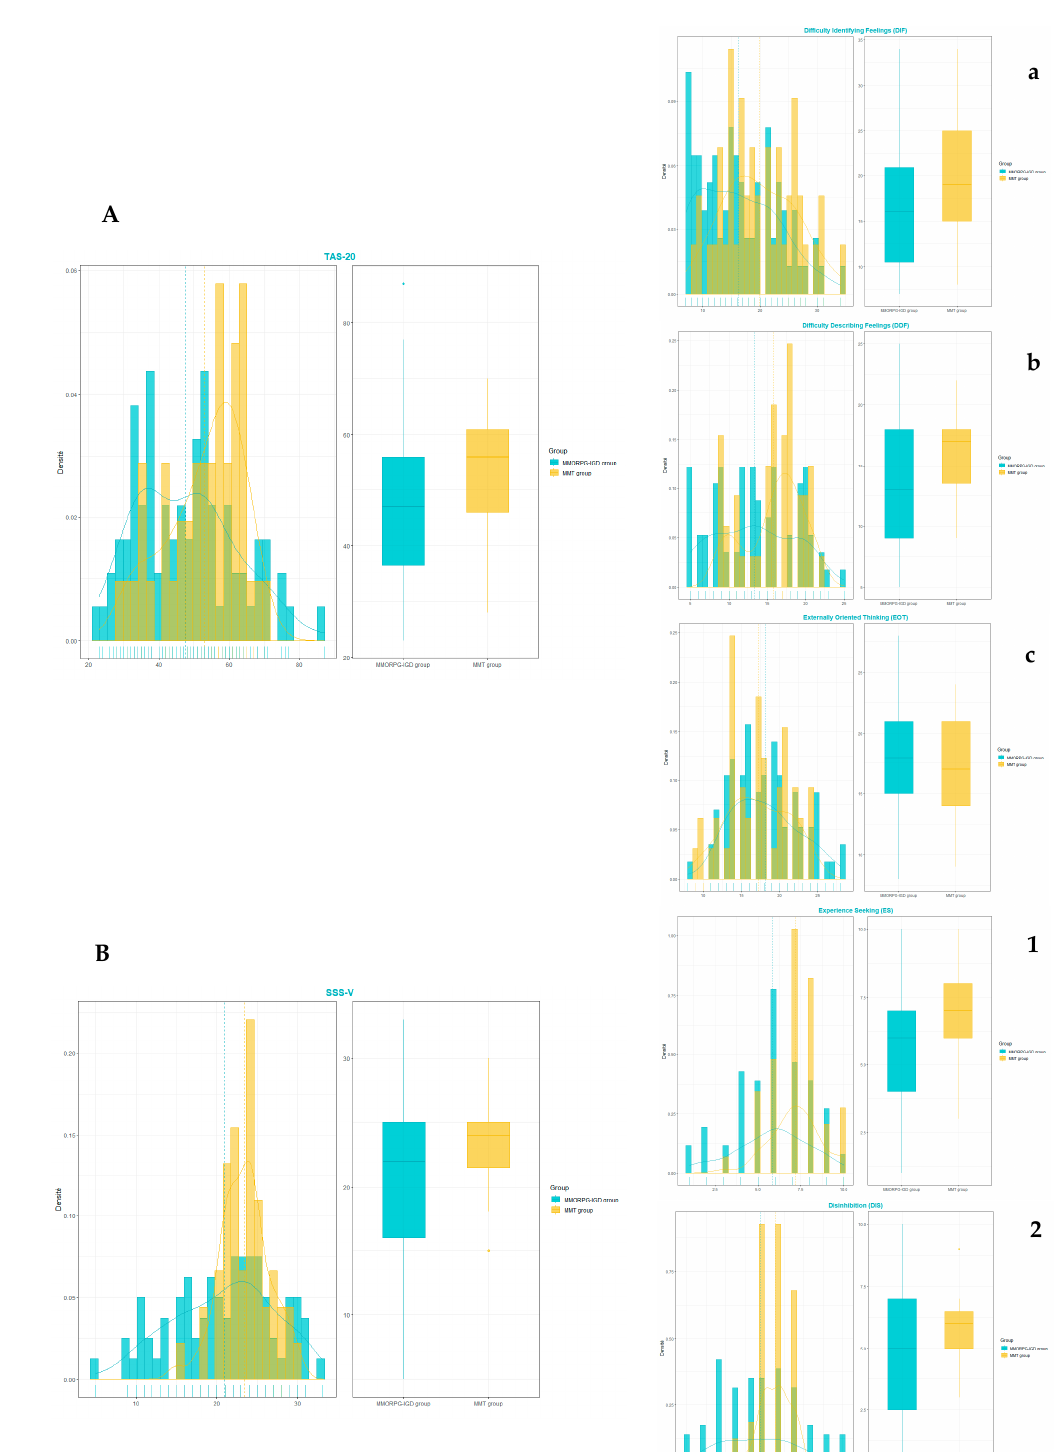
Figure 1. Histogram and box plot comparing the score distributions between MMORPG-IGD and MMT. ( A ) on the TAS-20 and its subcomponents, ( a ) Difficulty Identifying Feelings (DIF), ( b ) Difficulty Describing Feelings (DDF) and ( c ) Externally Oriented Thinking (EOT); ( B ) on the SSS-V and its subcomponents, ( 1 ) Experience Seeking (ES) and ( 2 ) Disinhibition (DIS). MMORPG-IGD, massively multiplayer online role-playing game internet gaming disorder; MMT, methadone maintenance therapy; TAS-20, Toronto Alexithymia Scale; SSS-V, Zuckerman Sensation Seeking Scale, form